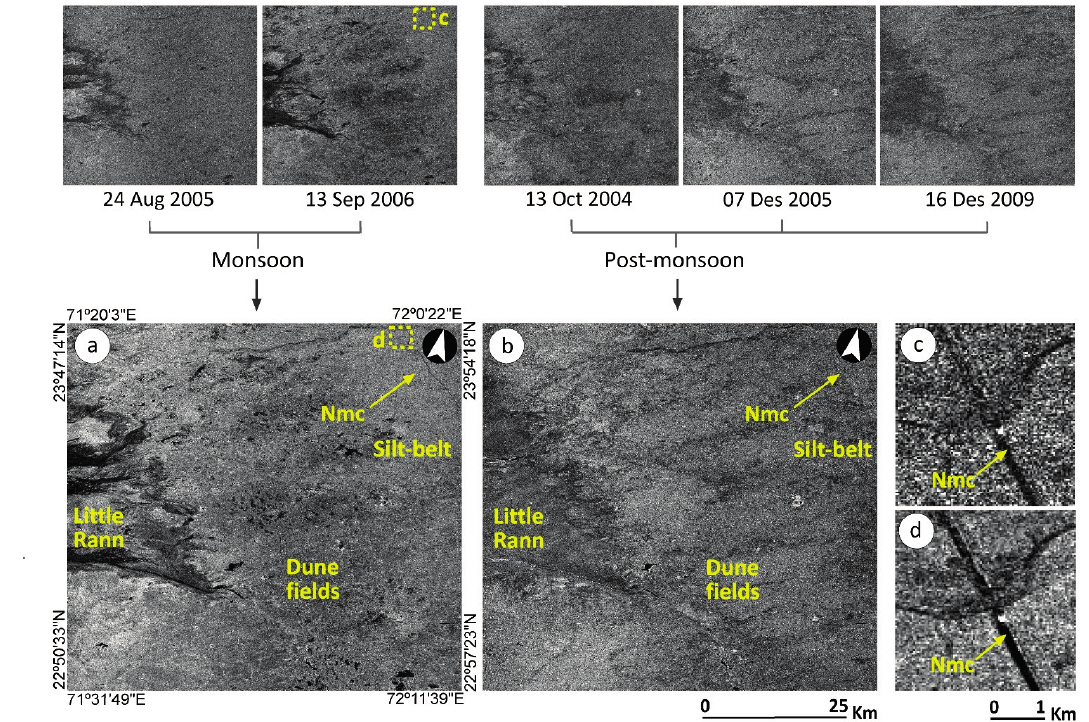
scenes; ( b ) Post-monsoonal MA image generated from three monsoonal scenes; ( c )